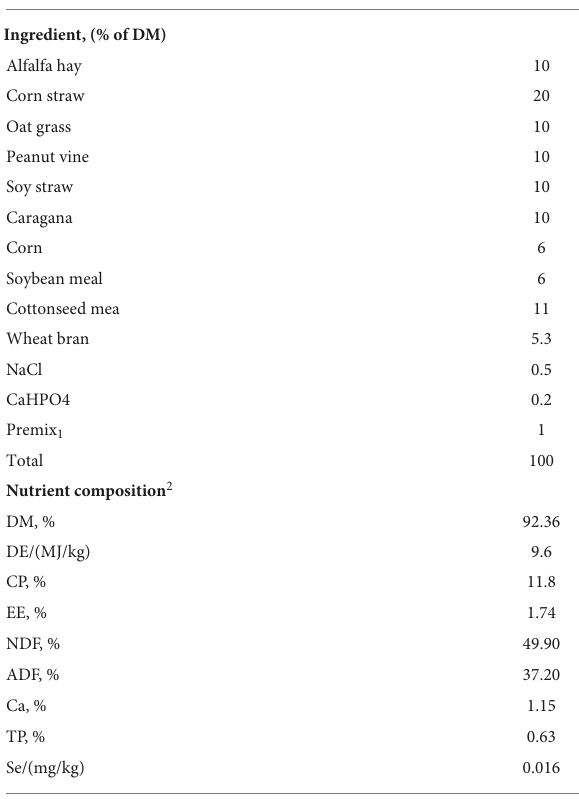
TABLE 1 The composition and ingredients of the basal